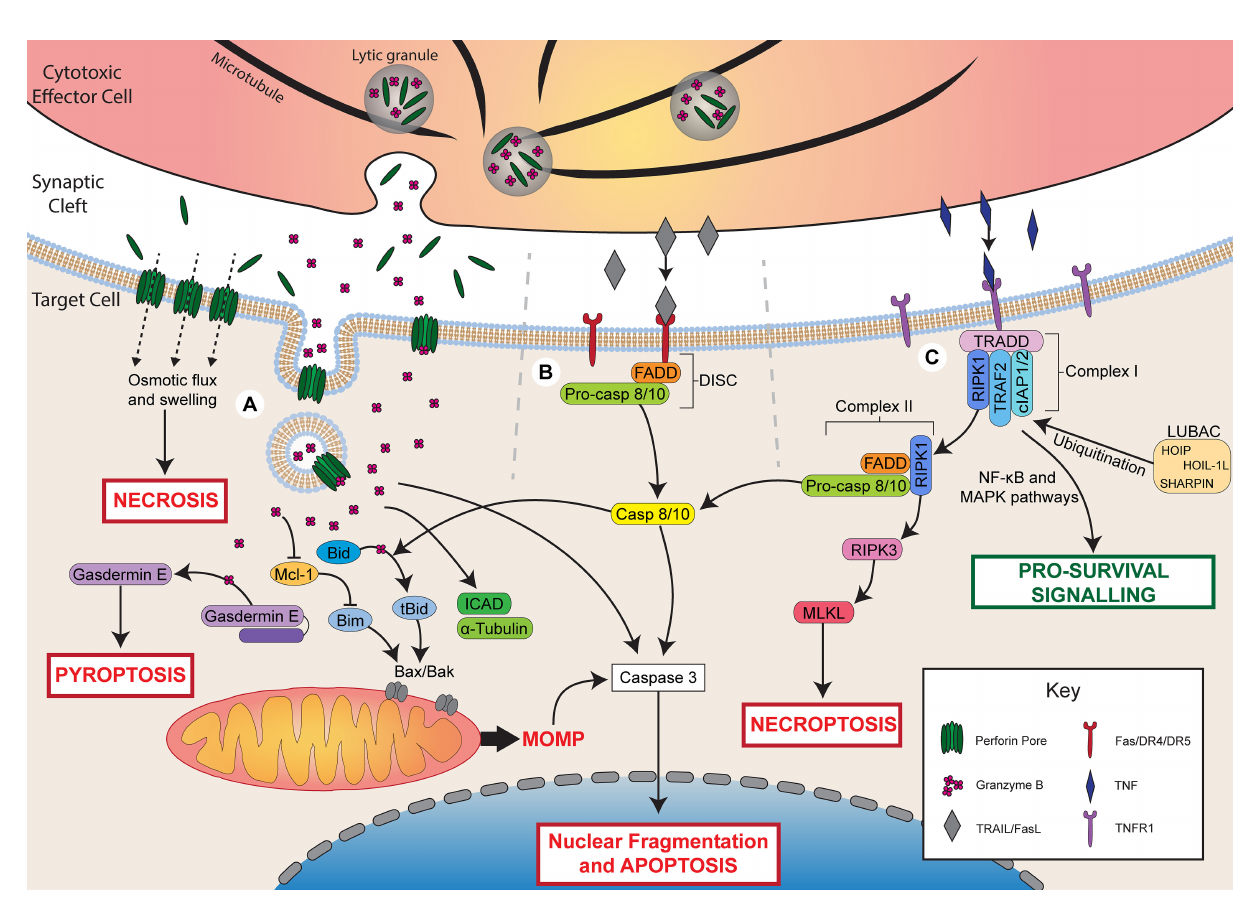
FIGURE 1 | Mechanisms of lymphocyte cytotoxicity. Following activation, cytotoxic effector cells can kill through granule-mediated cytotoxicity, death receptor- mediated cytotoxicity, or TNF-mediated cytotoxicity. (A) During granule-mediated cytotoxicity, perforin and granzymes are released from lytic granules into the synaptic cleft. Perforin forms pores in the target cell membrane. At high concentrations of perforin, osmotic fl ux through pores leads to cell swelling and necrotic cell death. Perforin can facilitate the uptake of granzyme B through direct diffusion or endocytosis. Granzyme B directly cleaves caspase 3 to induce apoptosis or triggers the mitochondrial apoptotic pathway via Bid cleavage into tBid. tBid recruits Bax/Bak leading to mitochondrial outer membrane permeabilization (MOMP) and apoptosis. Granzyme B may also degrade Mcl-1 releasing Bim to activate MOMP. Granzyme B can also cleave ICAD contributing to DNA damage, a -tubulin leading to cytoskeletal degradation, or gasdermin E, which forms pores in the cell membrane to induce pyroptosis. (B) Ligation of death receptors (Fas/DR4/DR5) by FasL or TRAIL triggers assembly of the death-inducing signalling complex (DISC) composed of FADD and pro-caspase 8/10. Caspase 8/10 induces apoptosis via direct caspase 3 cleavage or the mitochondrial apoptotic pathway via Bid cleavage. (C) Ligation of TNFR1 by TNF triggers the assembly of complex I (TRADD, RIPK1, TRAF2, cIAP1/2). LUBAC ubiquitinates complex I components leading to pro-survival signalling via NF- k B and MAPK pathways. In the absence of ubiquitination, RIPK1 dissociates and forms complex II with FADD and pro-caspase 8/10. Cleavage of pro-caspase 8/10 triggers apoptosis by the same pathways as FasL/TRAIL. In the presence of insuf fi cient pro-caspase 8, RIPK1 can also recruit RIPK3, which activates MLKL to trigger